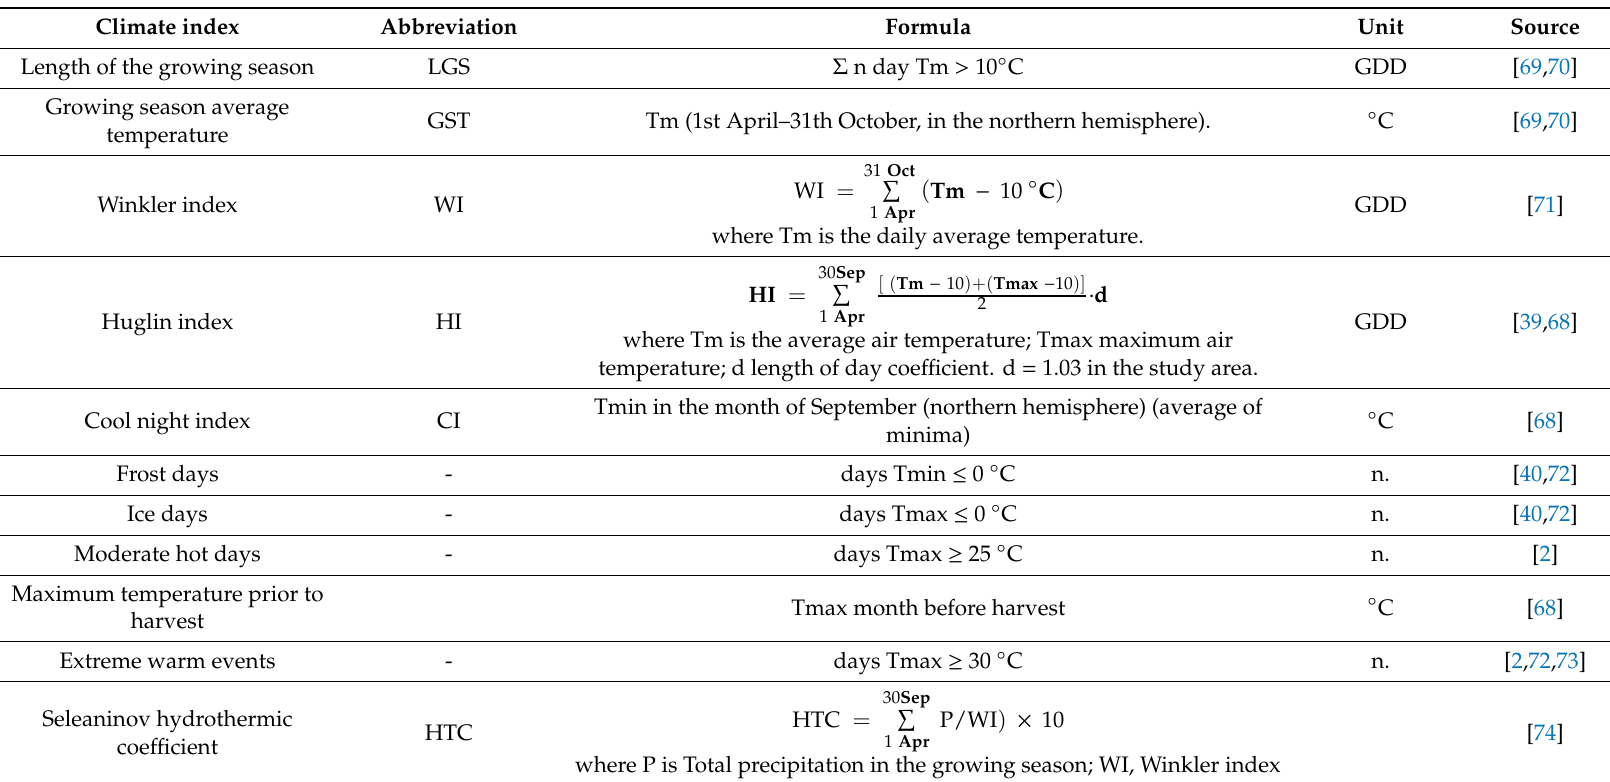
Table 1. Temperature-based bioclimatic indices used for climate characterization in the studied grape-wine growing